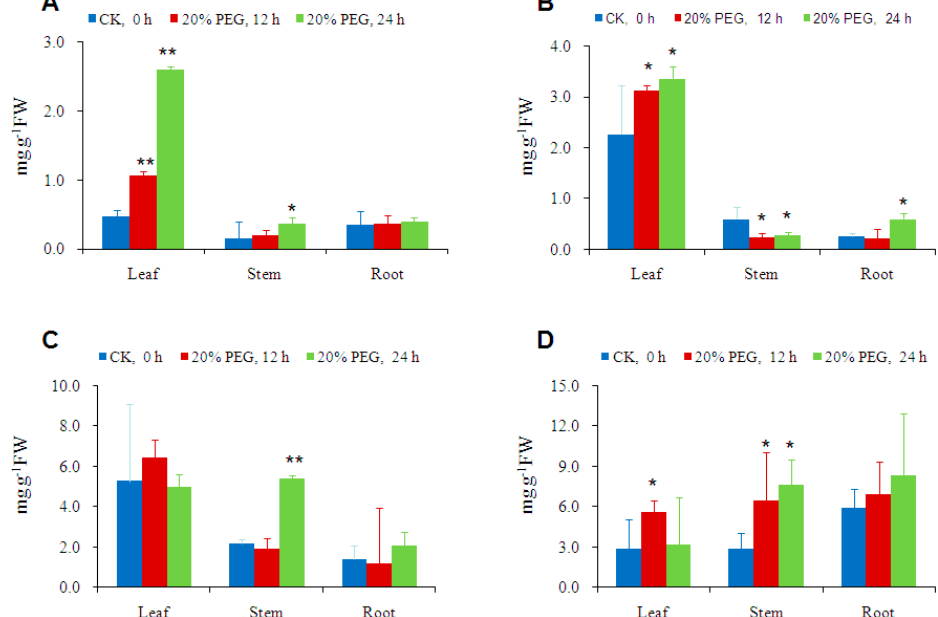
Figure 4. Changes of soluble sugar concentrations in different tissues of cassava (SC5) in response to 20% PEG treatment for 12 and 24 h: ( A ) Trehalose; ( B ) Fructose; ( C ) Glucose; and ( D ) Sucrose.